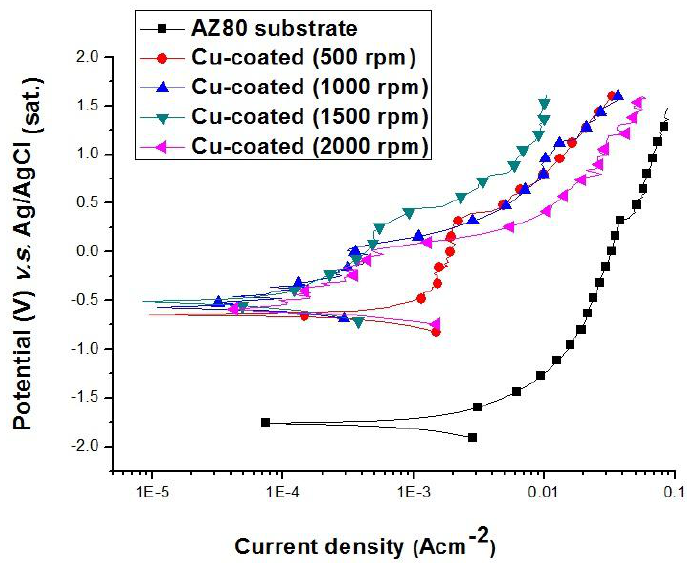
Figure 10. Anodic polarisation curves of uncoated and Cu-coated AZ80 RCEs with a U-shaped surface galvanostatically etched and Cu-electroplated at different rotation speeds in the alkaline bath.